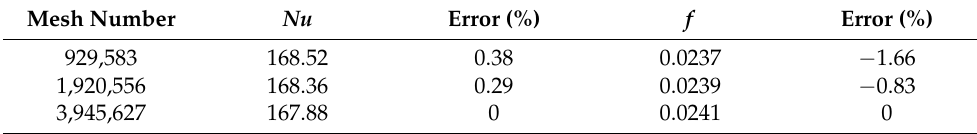
Table 2. Mesh-independence test for straight pipes.